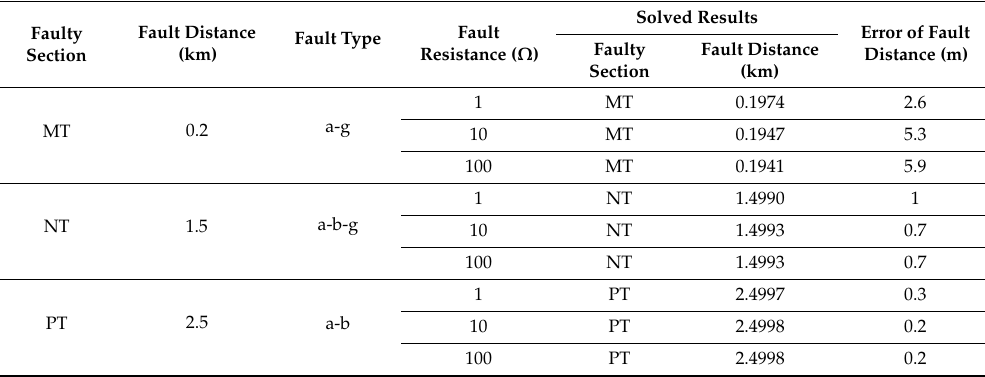
Table 5. Partial calculated results of the fault location in a tapped